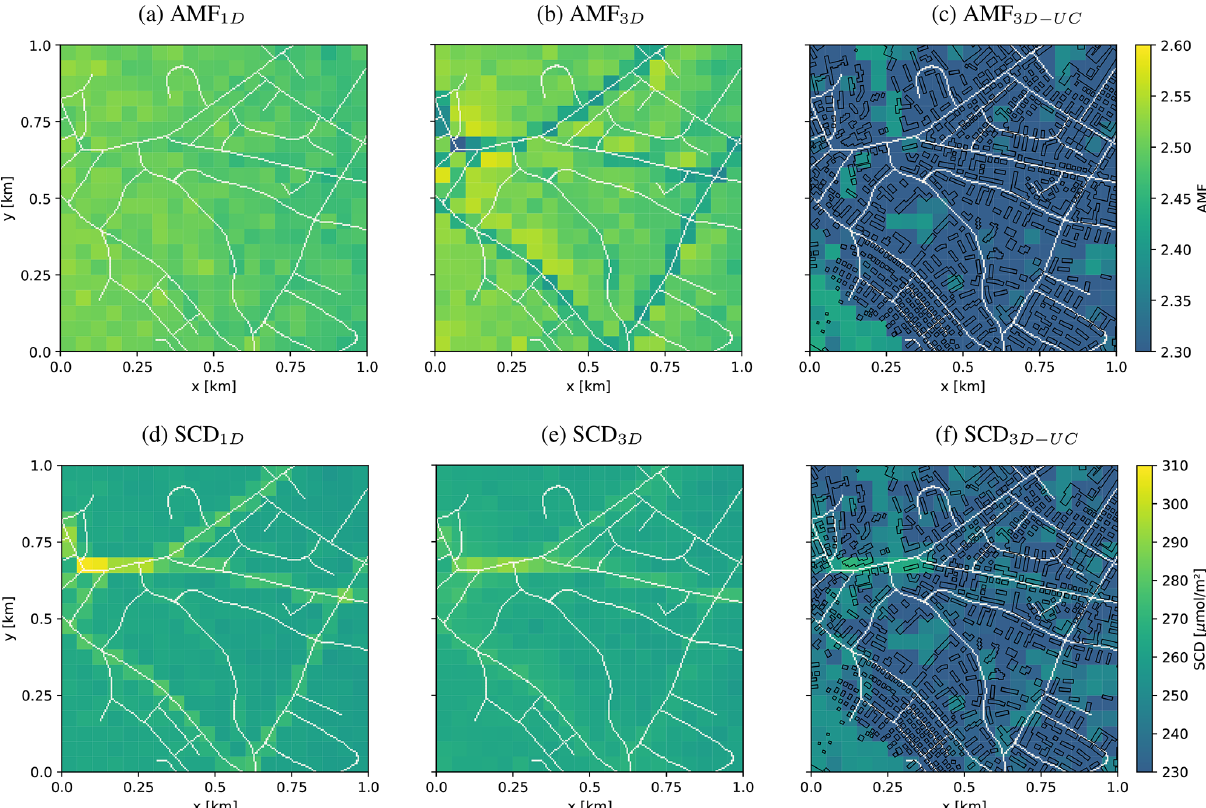
Figure 6. AMFs for a simulation with SAA of 90 ◦ with 1D-layer AMFs simulation (a) , 3D-box AMFs without (b) and with (c) buildings. The respective SCDs are shown in the lower row (d, e, f) . Roads are drawn in white and building contours in black for the simulation with